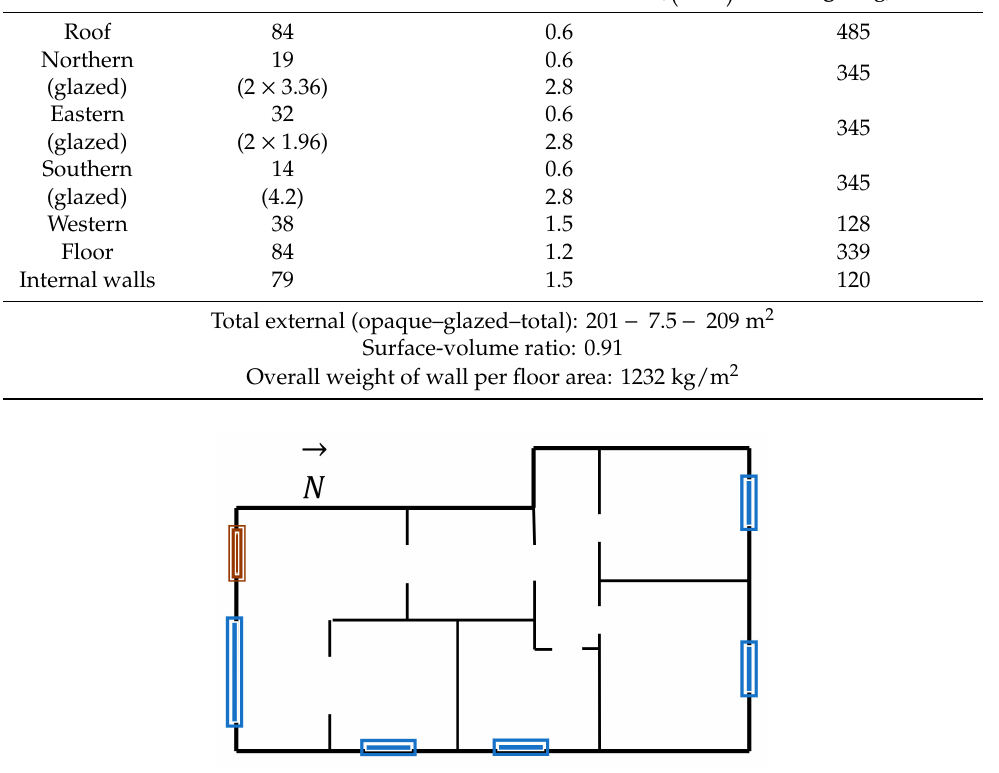
Figure 4. Scheme of the apartment (blue boxes are windows, while the brown box is the main door).